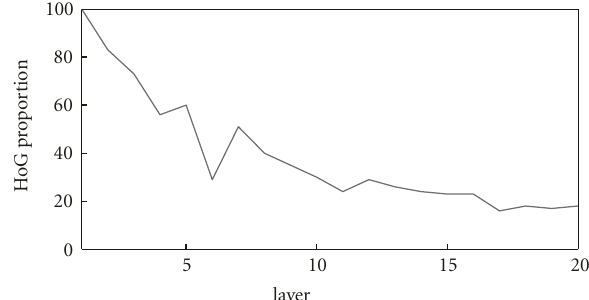
Figure 9: Proportion of chosen HoG features for each layer in the cascade for fusion detector.